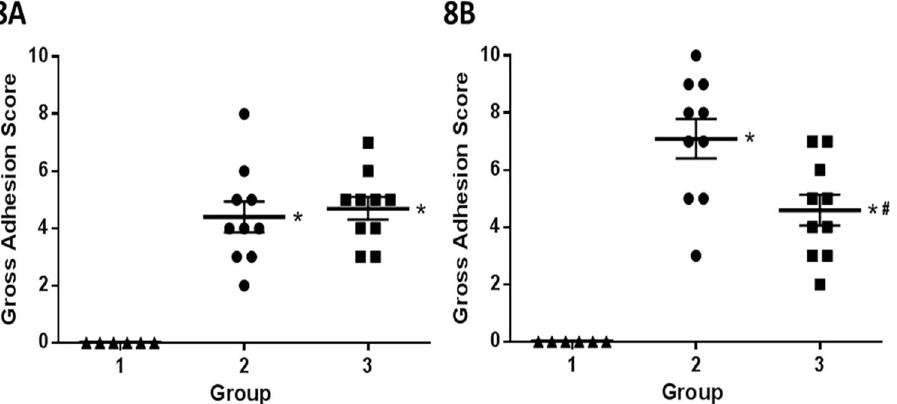
Figure 8. The gross adhesion scores of the postsurgical adhesion mouse model ( A ) one day or ( B ) seven days after the operation. At one day after the operation, the scores from Group 2 (operation, n = 10) and Group 3 (operation with 10 mg/kg QLT-0267 treatment, n = 10) were significantly higher than Group 1 (sham operation, n = 6). At seven days after the operation, the scores from Group 2 were significantly lower than Group 1, while the scores from Group 3 were significantly lower than Group 2. * P < 0.05 vs. Group 1; # P < 0.05 vs. Group